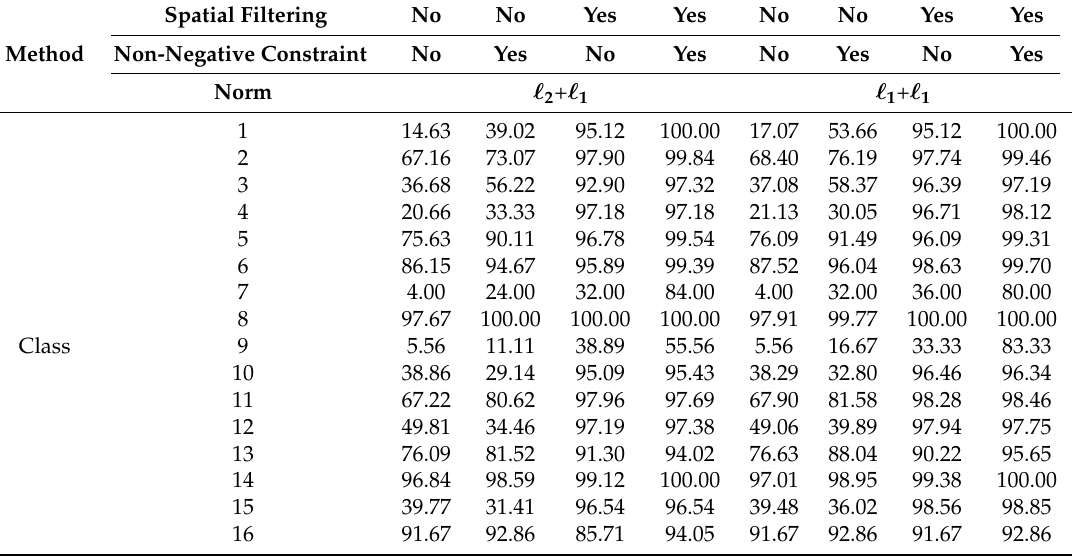
Table 3. Overall Accuracy, Average Accuracy, Kappa Statistic and Time of the Indian Pines data set when using pixel-wise